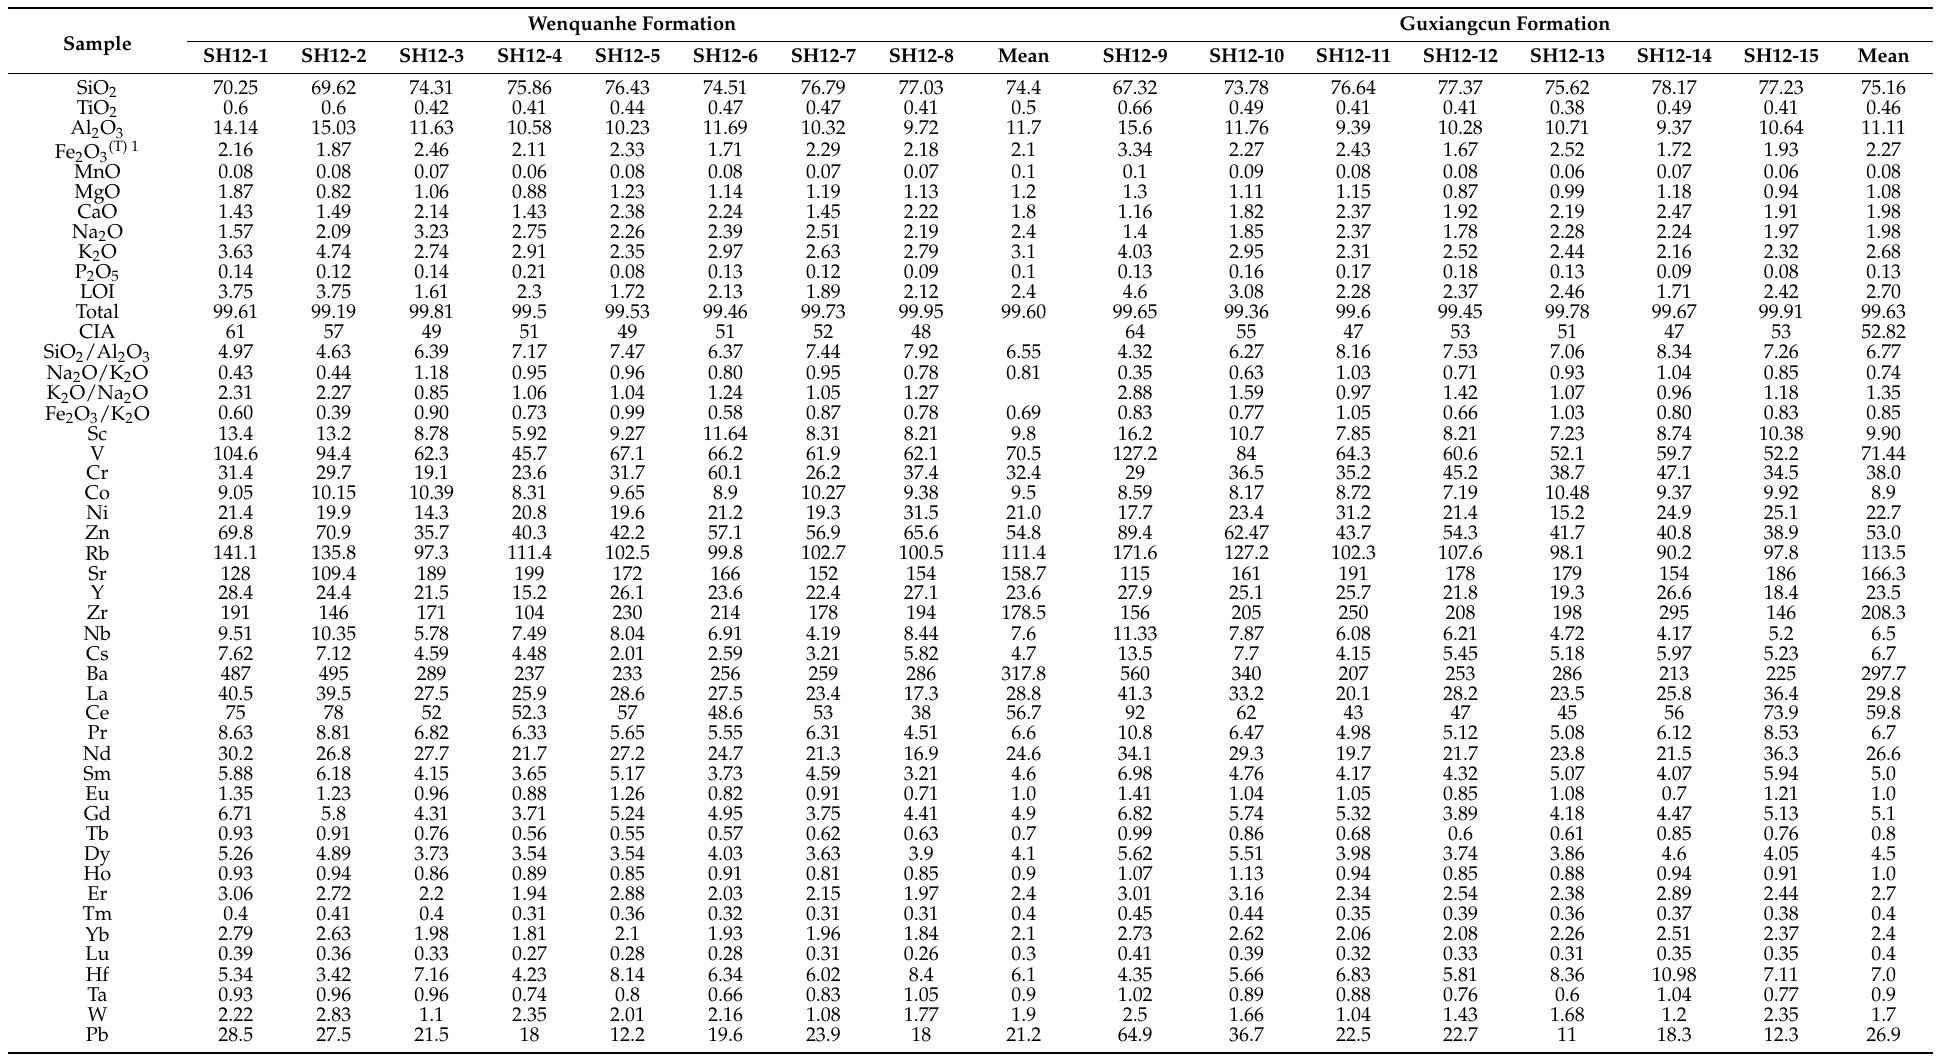
Table 1. The major and trace elements of sediments from the Songhua